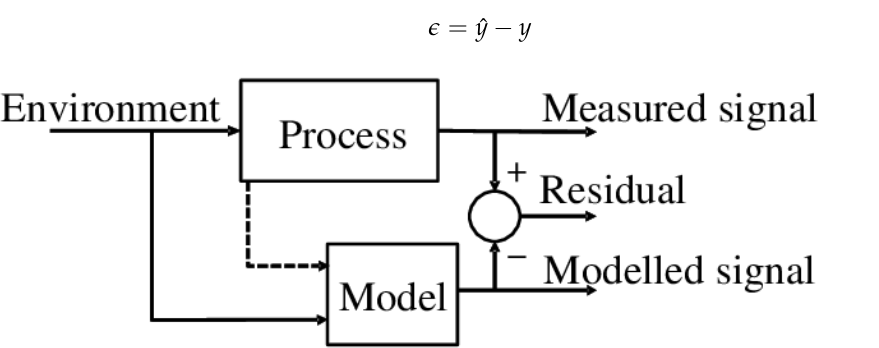
Figure 5. Schematic illustration of anomaly detection. Reproduced from [4] which is distributed under CC BY-NC-ND 4.0 Licence. Details of the license are available at https://creativecommons. org/licenses/by-nc-nd/4.0/ 8 July